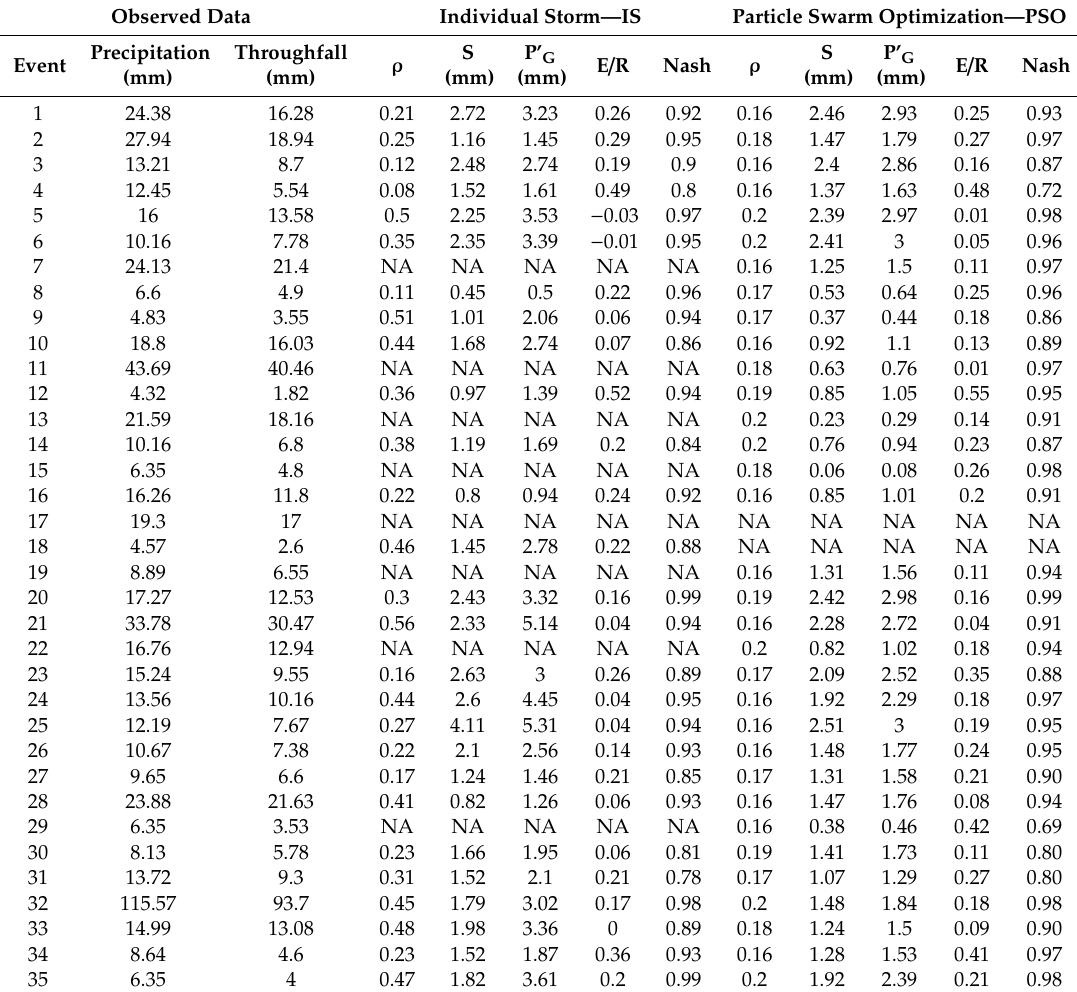
Table 2. Summary of the rainfall events and Gash model parameters obtained by the IS method and PSO optimization. Observed Data Individual Storm—IS Particle Swarm